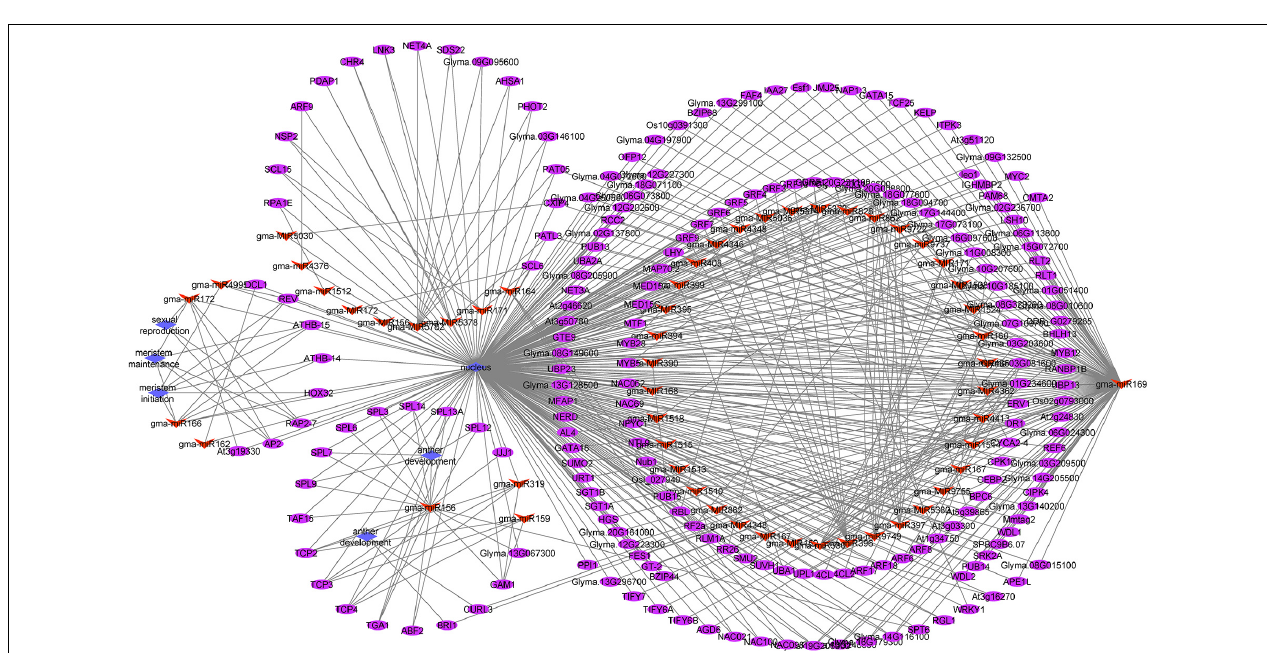
FIGURE 4 | The GO and KEGG pathway analyses of the differentially expressed genes between JLCMS9A and JLCMS9B. (A) Top 20 GO terms. The x -axis presents the GO terms, whereas the y -axis presents the enrichment factors. (B) Top 15 KEGG pathways. The x -axis presents the KEGG pathways, whereas the y -axis presents the enrichment factors.